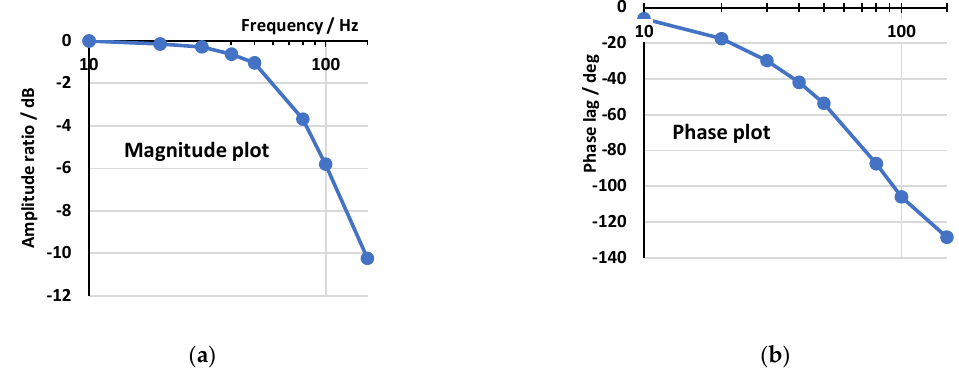
Figure 12. Bode Plot for input amplitude = 0.4 mm ( p p − p T = 70 bar, C p = 90 Ns/m, m p = 80 g; ω n , a = 1400 rad/s): ( a ) magnitude plot; ( b ) phase plot.